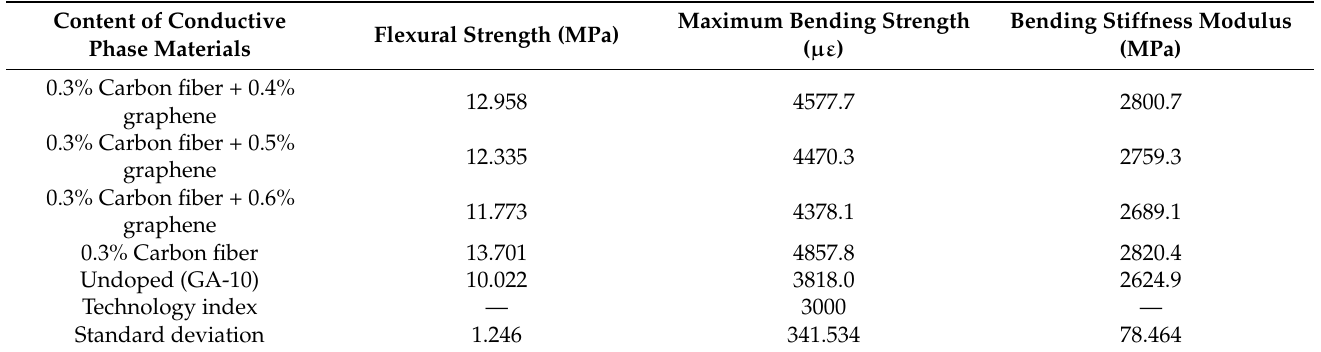
Table 13. Results of low-temperature bending test of asphalt